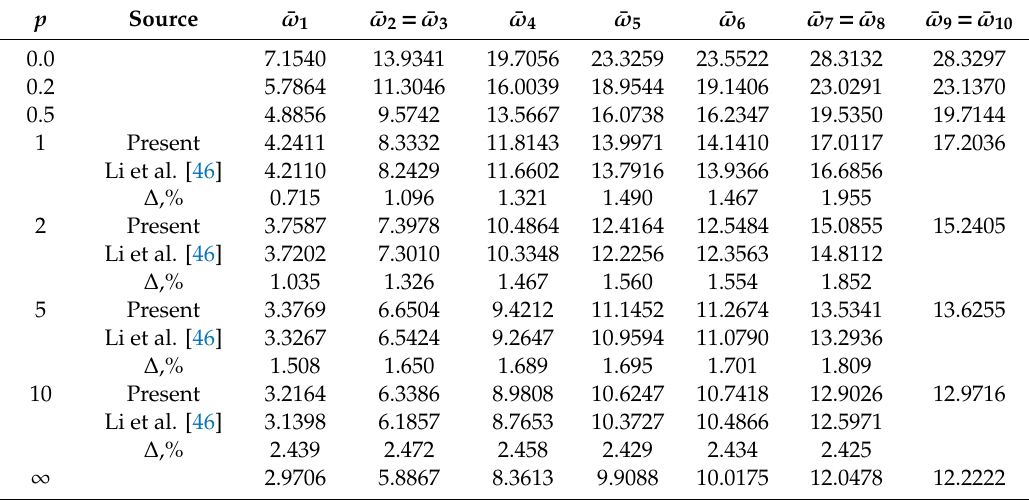
Table 4. The first ten nondimensional frequencies of fully clamped (CCCC) SUS304 / Si 3 Ni 4 functionally graded square plates thermally loaded by the uniform temperature rise, T = 600